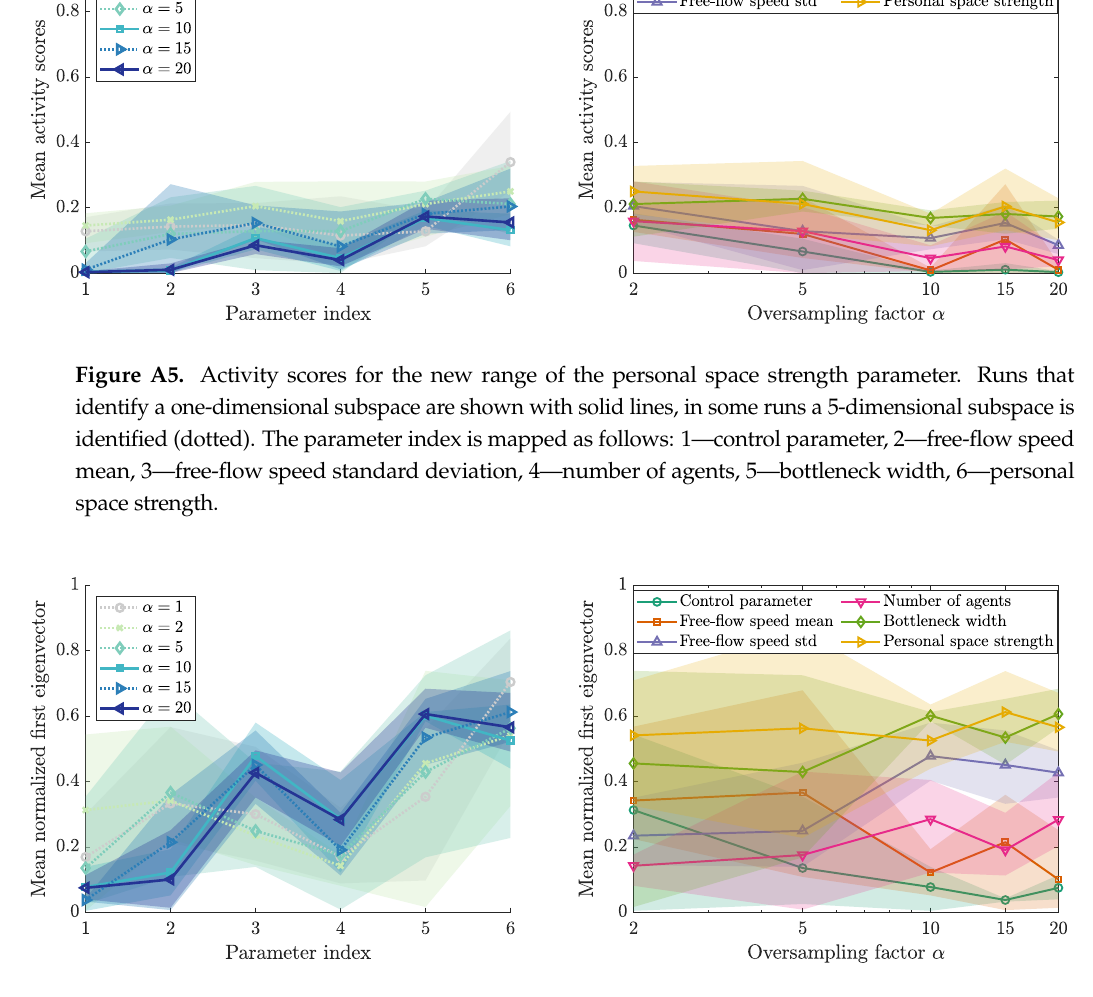
Figure A6. Normalized first eigenvector metric for the new range of the personal space strength parameter. Runs that identify a one-dimensional subspace are shown with solid lines, in some runs a higher dimensional subspace is identified (dotted). The parameter index is mapped as follows: 1—control parameter, 2—free-flow speed mean, 3—free-flow speed standard deviation, 4—number of agents, 5—bottleneck width, 6—-personal space